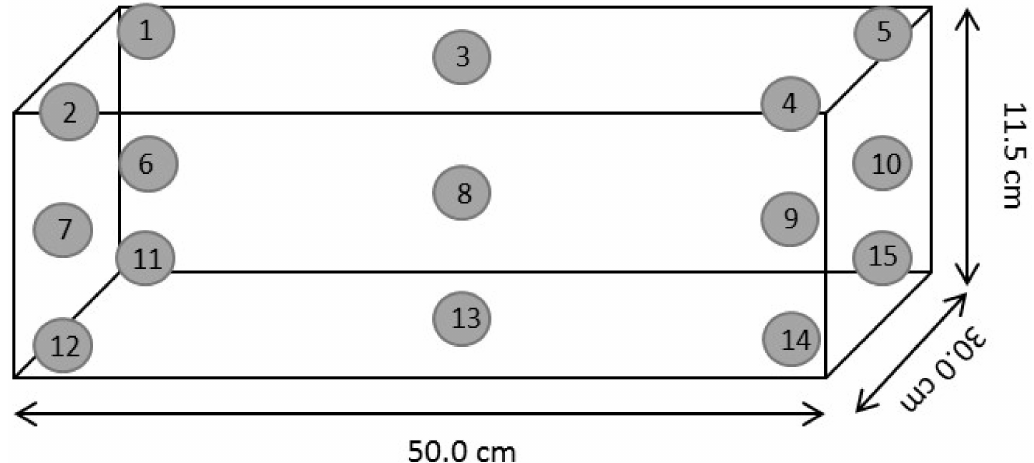
Figure 1. Position of alanine pellets for dose mapping in boxes filled with strawberry